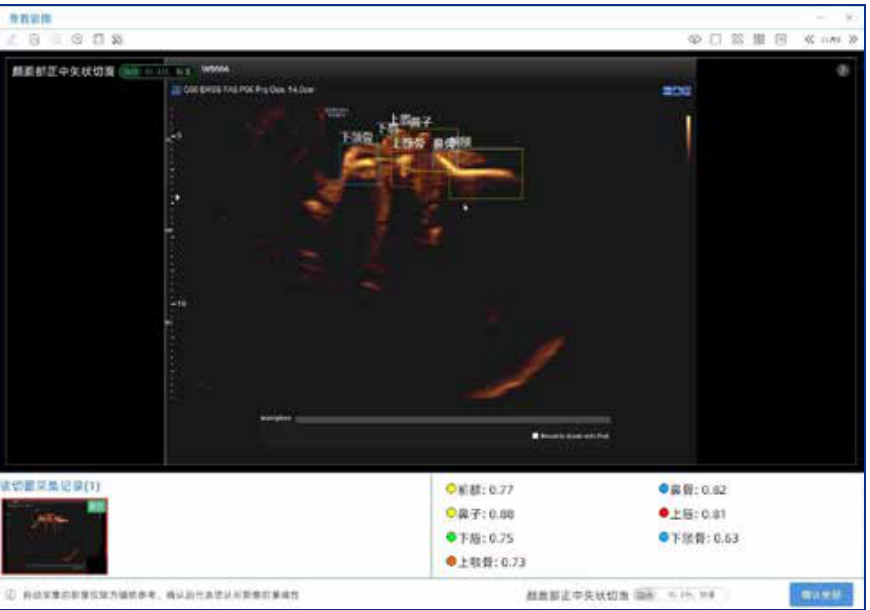
Figure 5 Image viewing interface of the intelligent PACS. The intelligent quality control score is displayed in the upper left corner. The intelligent standard anatomical structures are marked in each specific anatomical location of the image, and the quality control details for each structure are shown in the lower right corner.